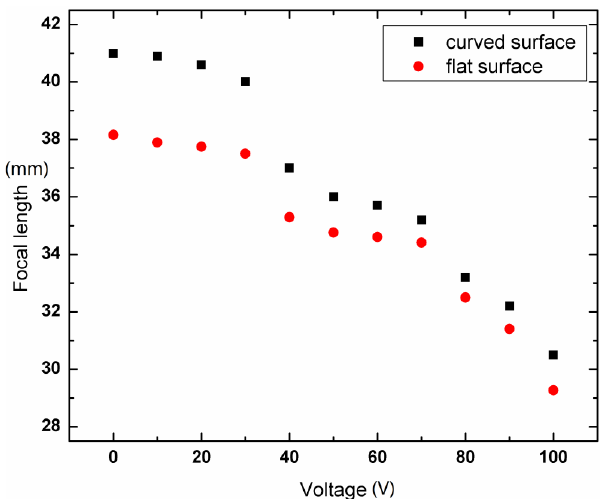
Figure 5. Focal length versus applied voltage. The curved surface is the protection glass shown in Figure 3c and it has no optical power. On the curved surface, the lens has a slightly longer focal length than that on a flat